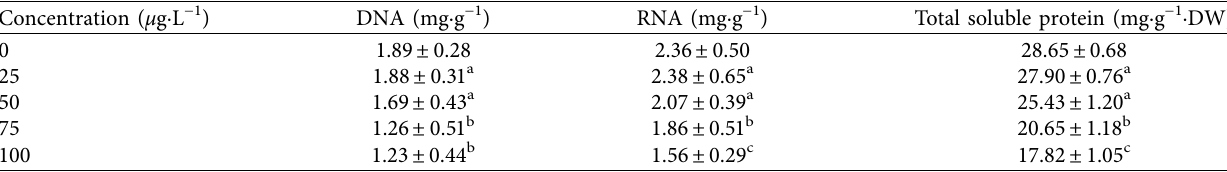
Table 4: Efect of diferent concentrations of AgNPs on DNA, RNA, and total soluble protein contents of wheat seedlings after 10 days. Concentration ( μ g · L − 1